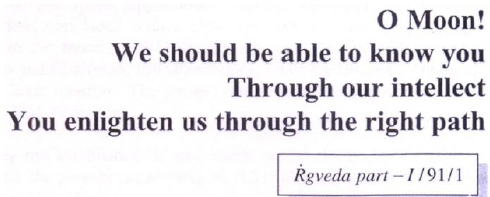
Figure 13. A Sanskrit shloka (verse) from an ancient Indian scripture, Rigveda, originating in ~1500 BCE. Credit: ISRO Somayaan Project